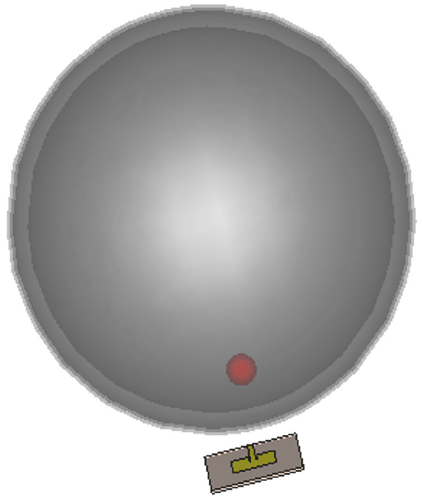
Figure 7: Simulation setup for the considered brain imaging